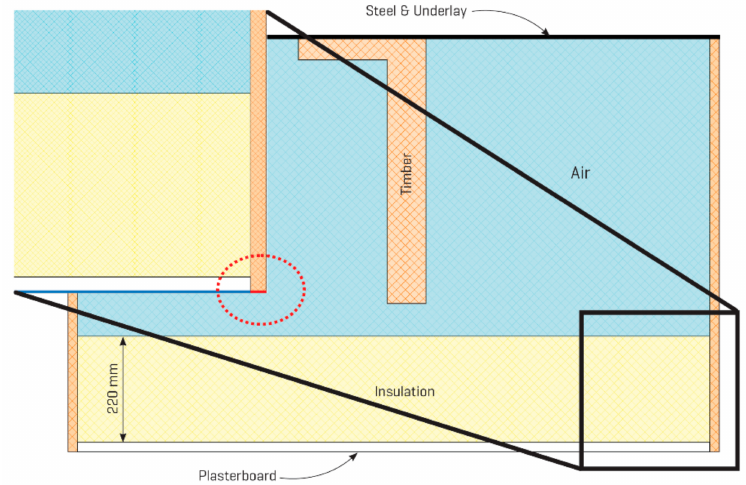
Figure 2. Section of the WUFI ® 2D geometry. The artificial boundary (red element) is used to provide a distinct external climate for the ventilation air. Heat transfer and diffusion thickness parameters have been set such that there is no flow across this boundary. The 50:50 mix of internal/external air was applied to this